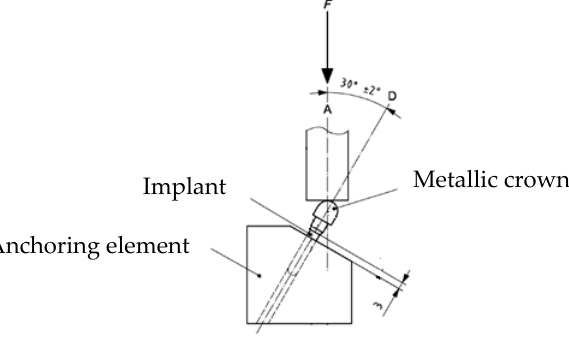
Figure 3. Installation scheme of the assembly.